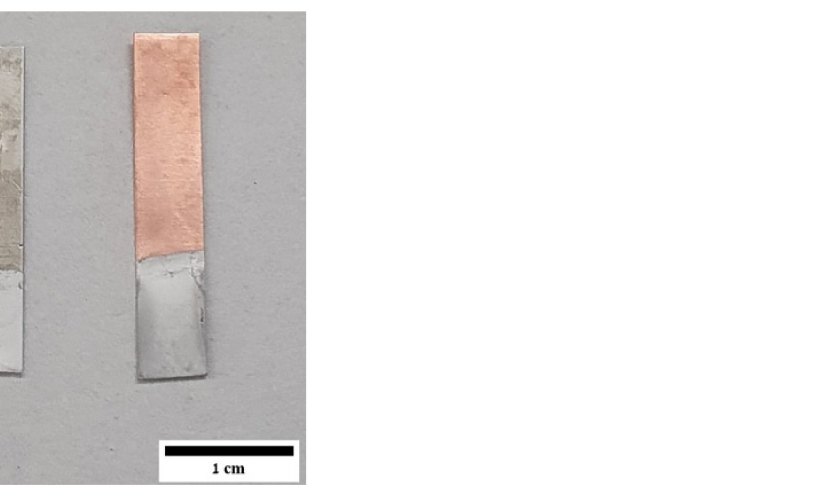
Figure 8. CCD images of Al electrodeposits (bottom parts) on Ni and Cu substrates. Deposition potential: − 1.3 V.